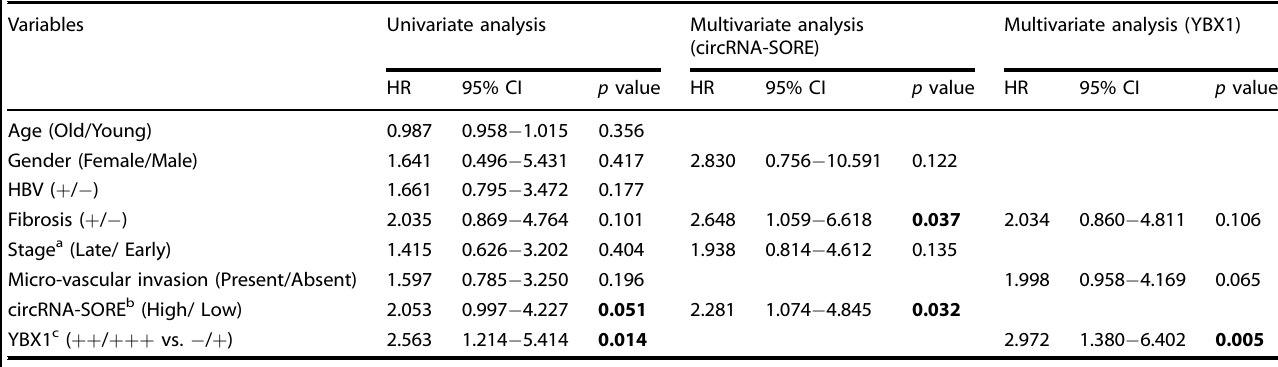
Table 2. Results of univariate and multivariate analysis of clinicopathological factors for recurrence-free survival (Cox proportional hazard model) Variables Univariate